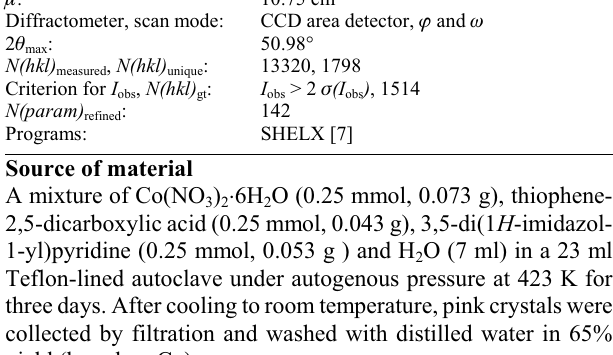
Table 2. Atomic coordinates and displacement parameters (in Å 2 )